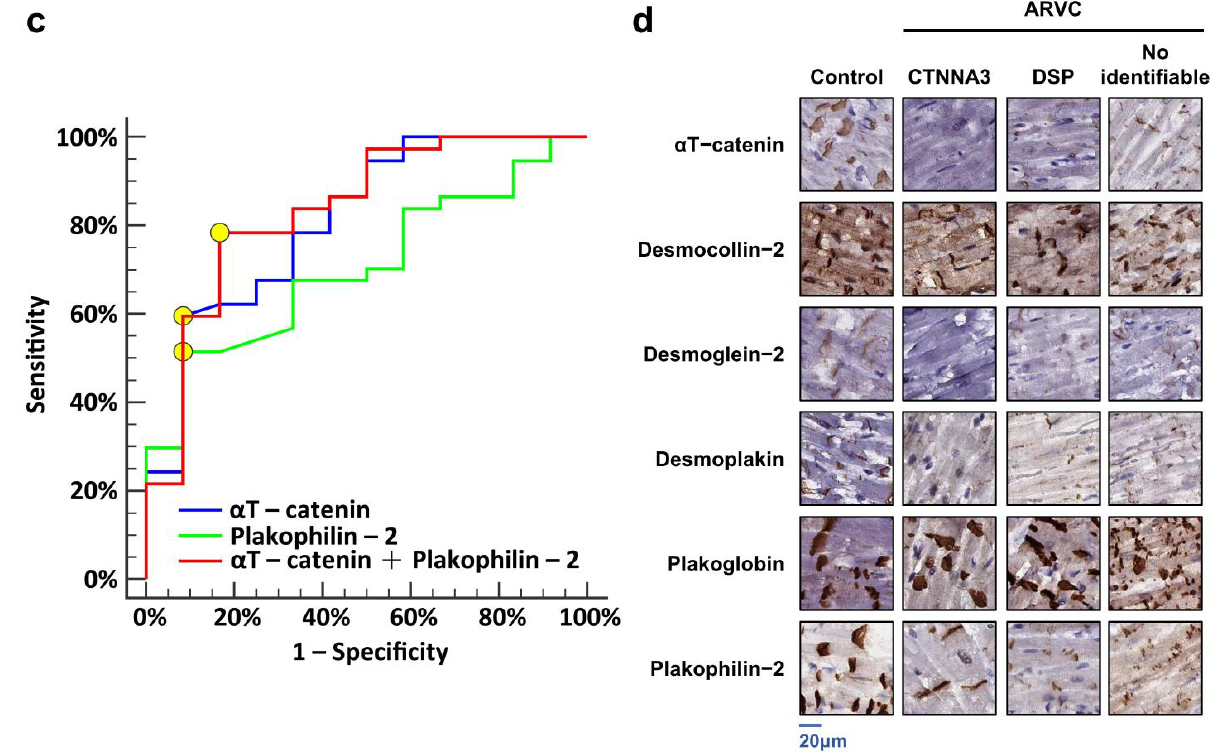
Figure 1. Representative immunohistochemical images of myocardial tissue from controls and ARVCs with different gene mutations. ( a ) The right ventricle obtained from the autopsy was assessed via IHC staining using the indicated antibodies. The immunoreactive intensity was evaluated using ImageJ, and the results are presented in Table 1. ( b ) Heatmap of protein expression in ARVC. The immunoreactive intensity was assessed using ImageJ, and the delta value was calculated to form a heatmap. Positive delta values (red) indicated that the expression of proteins was higher in patients with ARVC than those in controls, whereas a negative delta value (green) showed that the expression of proteins was lower in patients with ARVC than in controls. ( c ) Receiver operating characteristic curve for the prediction of ARVC based on the levels of αT -catenin and plakophilin- 2, as measured on IHC staining. ( d ) Expression of desmosomal proteins in the ICD structure. Results showed one representative control case and ARVC cases with different gene mutations.